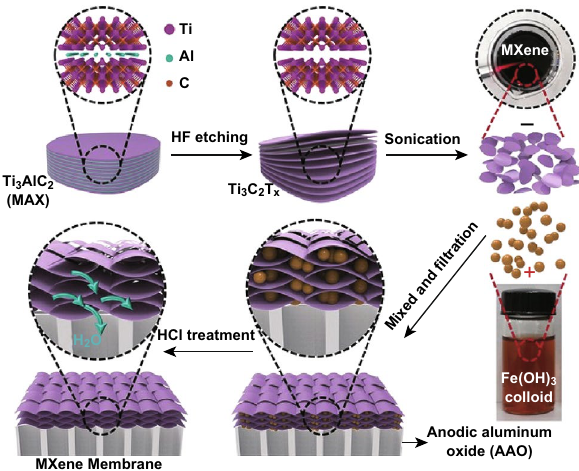
Fig. 6 Schematic of MXene membrane preparation via HF etching and intercalation by using Fe(OH) 3 colloidal solution. Reprinted with permission from Ref. [53]. Copyright © 2017 John Wiley & Sons,